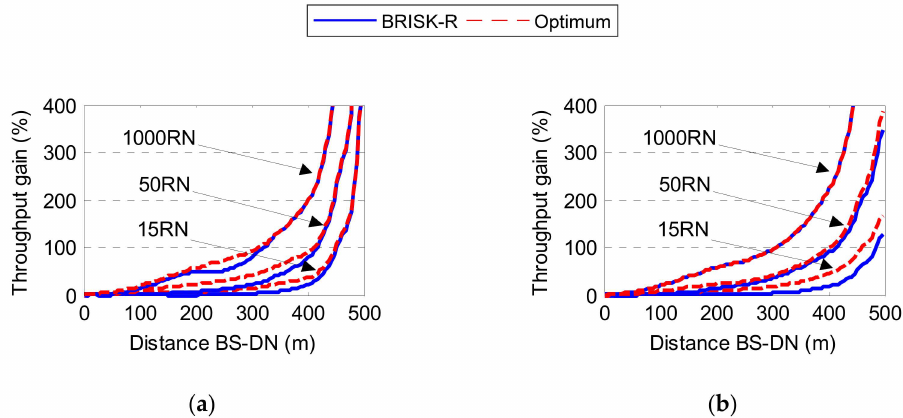
Figure 17. Throughput gain obtained with BRISK-R and the Optimum scheme with respect to SH when applied MAXIHU and MinP RRM schemes—web tra ffi c & homogeneous scenario. ( a ) MAXIHU; ( b )